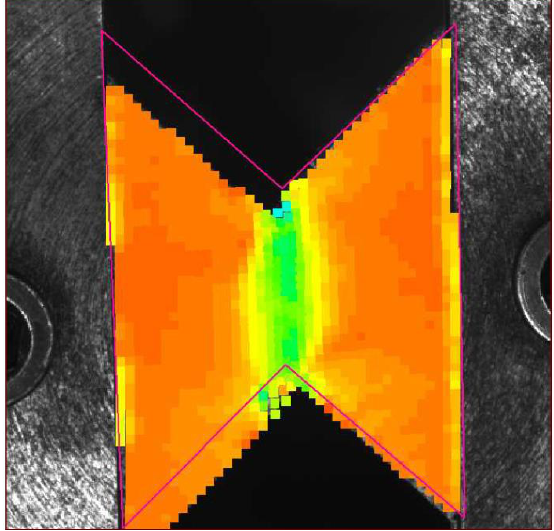
Figure 16. Illustration of the shear deformation of the “Batman”-shaped specimen.